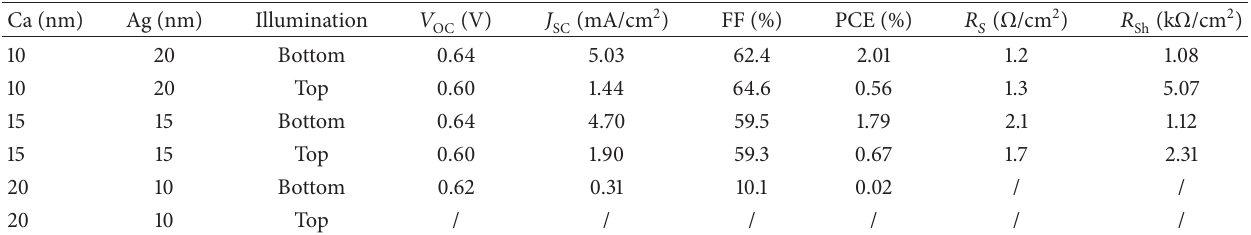
Figure 3: 𝐽 - 𝑉 characteristics of devices MoO 3 (2nm)/Ag (9nm)/MoO 3 (10nm)/P3HT:PCBM/Ca/Ag with different thickness combination of Ca and Ag as the cathodes when illuminated from the (a) anode side and (b) cathode side. Corresponding dark 𝐽 - 𝑉 curves are also shown in (a) for comparison. Table 1: Photovoltaic performance parameters of ITO-free semitransparent OSCs with different thickness combination of Ca and Ag as the cathodes illuminated from the anode (bottom) and cathode (top)